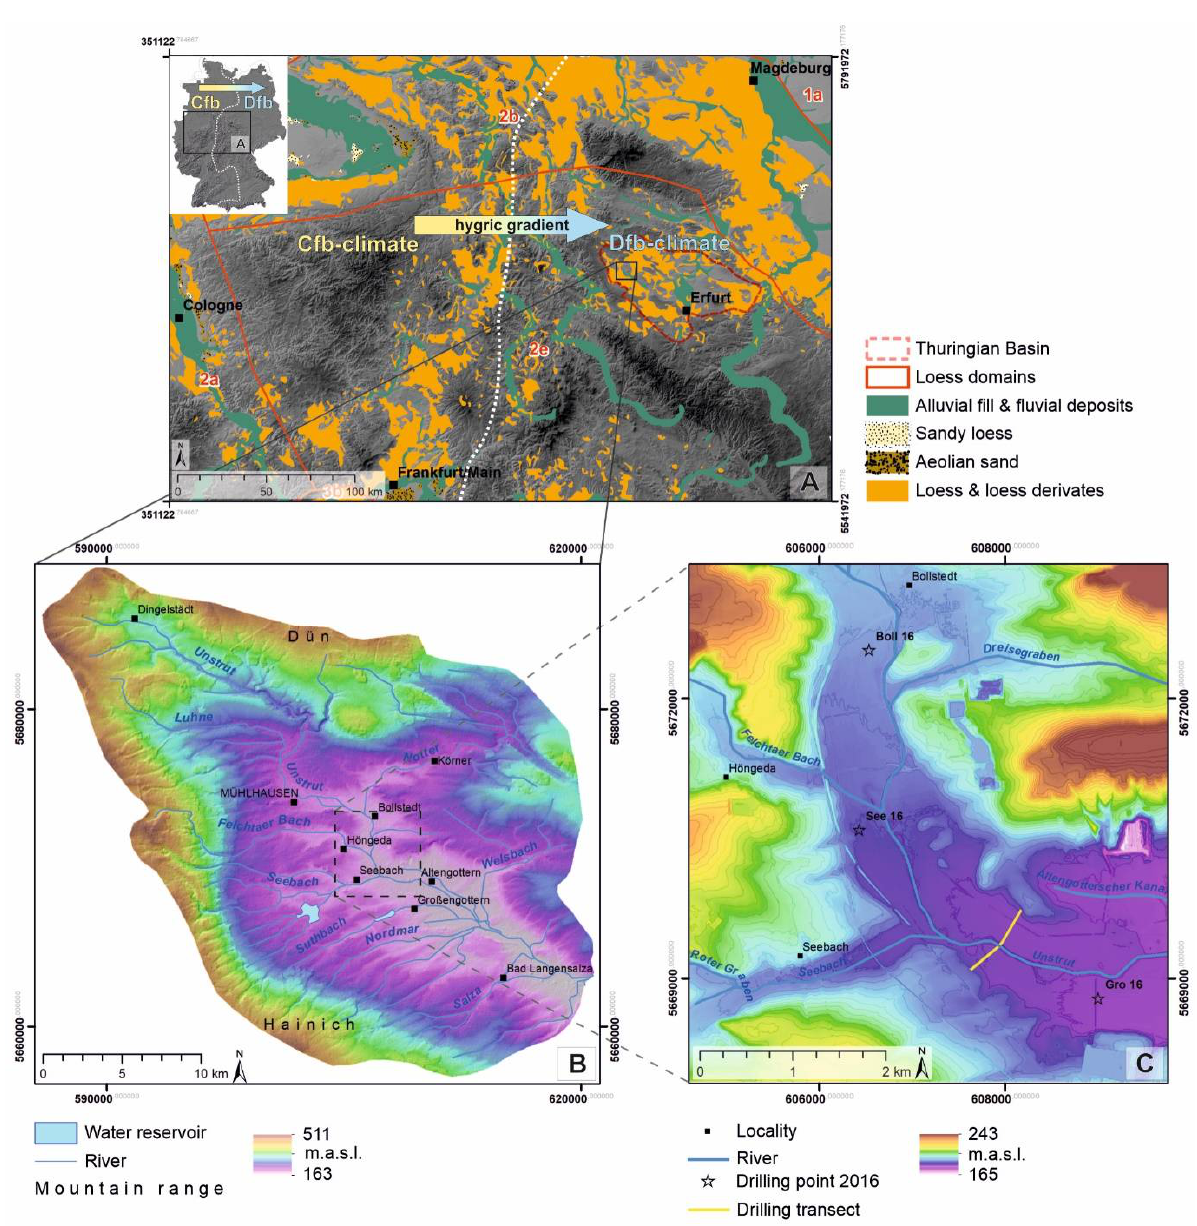
Figure 1. ( A ) Location of the Unstrut catchment of central Germany within a Central European loess landscape, subdomain 2e [34] (DEM200: BKG2018). The meridional climate boundary between Cfb and Dfb climates is indicated by the dotted white line [38]. ( B ) Upper Unstrut catchment from the headwater area near the village of Dingelstädt to the gauging station Nägelstädt (A eo = 716 km 2 ) (SRTM: USGS, VG250: BKG2018). ( C ) Detailed map of the investigated area southeast of Mühlhausen showing locations of cross-section and initial drillings achieved during 2016 (DEM5: BKG2018). Coordinate system: ETRS 1989 UTM Zone 32N.